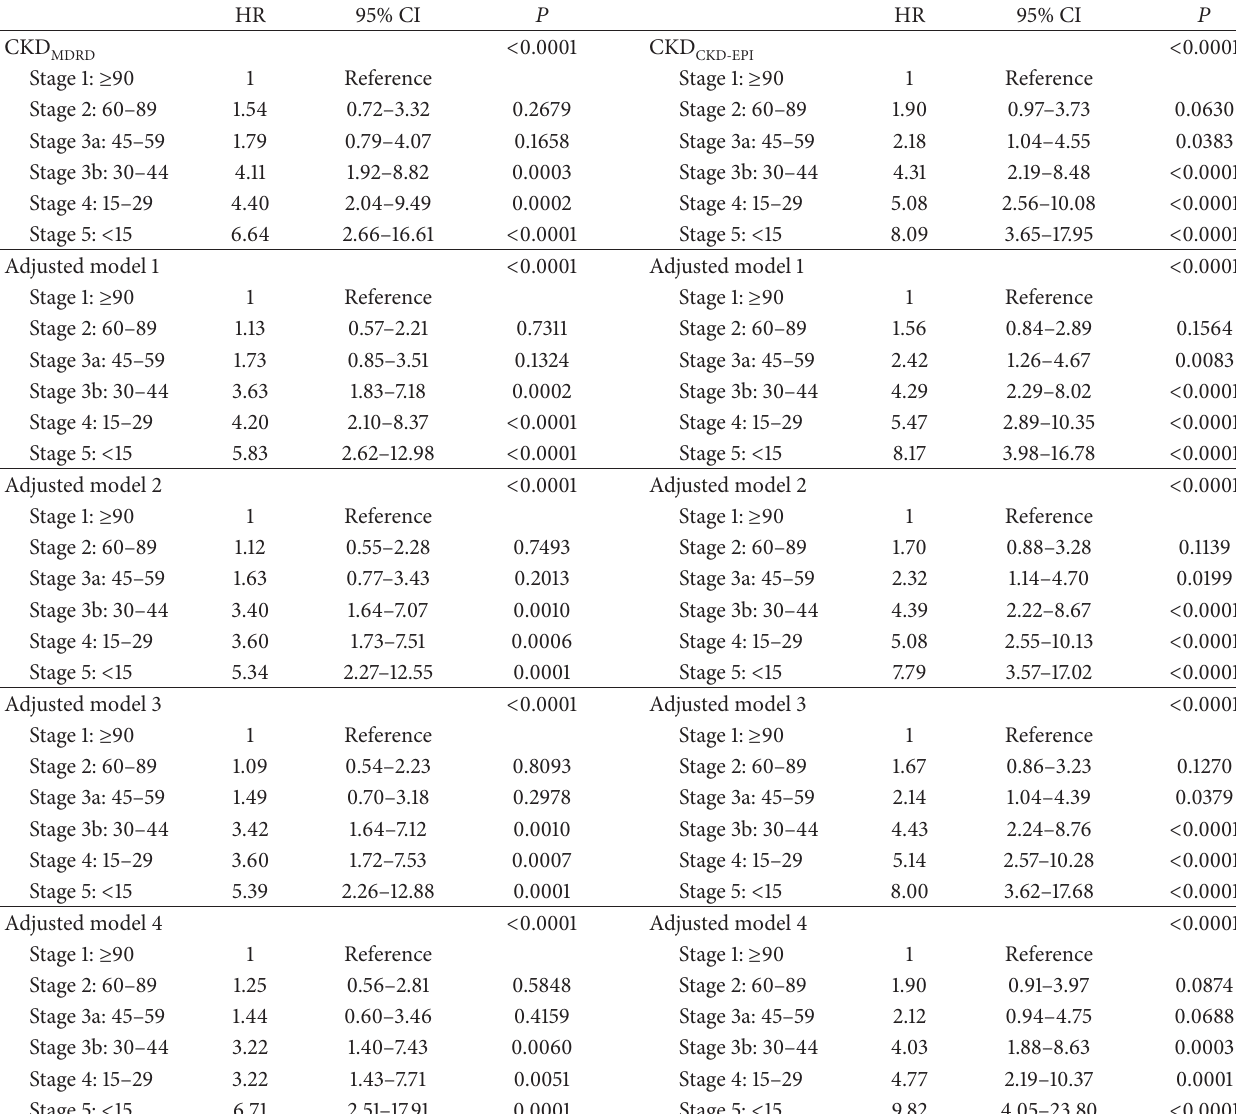
Table 2: Crude and adjusted Cox proportional hazard ratios for doubling of baseline serum creatinine level in 707 type 2 diabetic patients with nephropathy stratified by CKD stage according to each